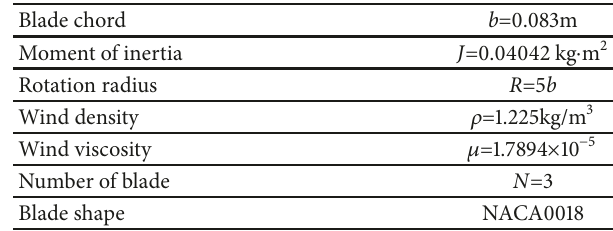
Table 2: Characteristic parameters of the